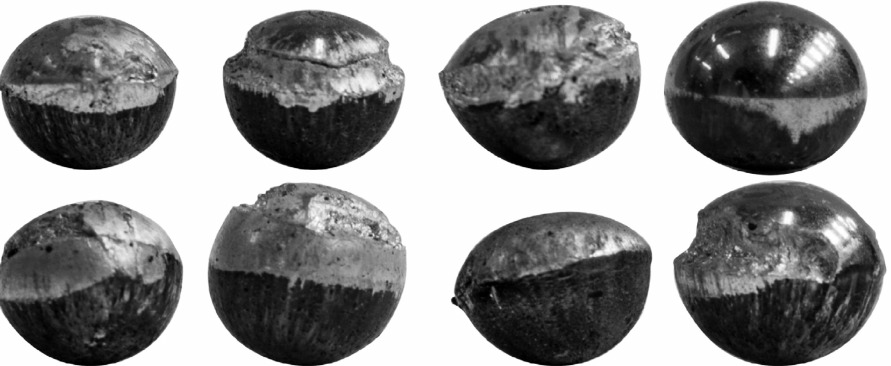
Figure 2. Photographs of typical 5 mm diameter blast-driven ball bearings showing damage on the two hemispheres after loading under a range of explosive charges and aspect ratios.